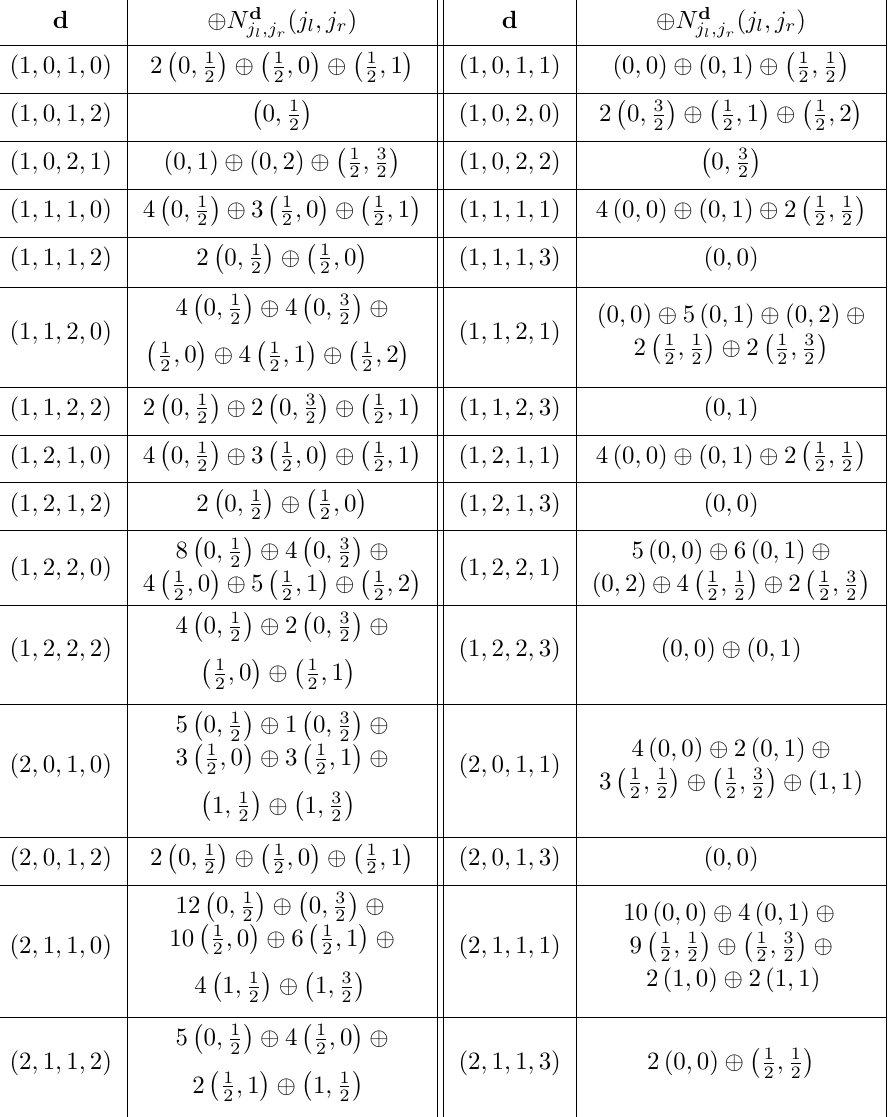
Table 24. BPS spectrum of the G 2 + 1 Adj for d 1 = 1 , d 2 , d 3 ≤ 2 and d 1 = 2 , d 2 , d 3 ≤ 1 . Here, d = ( d 1 , d 2 , d 3 , d 4 ) labels the BPS states with charge d 1 m 0 + d 2 α 1 + d 3 α 2 + d 4 m 1 , where d 4 ↔ − d 4